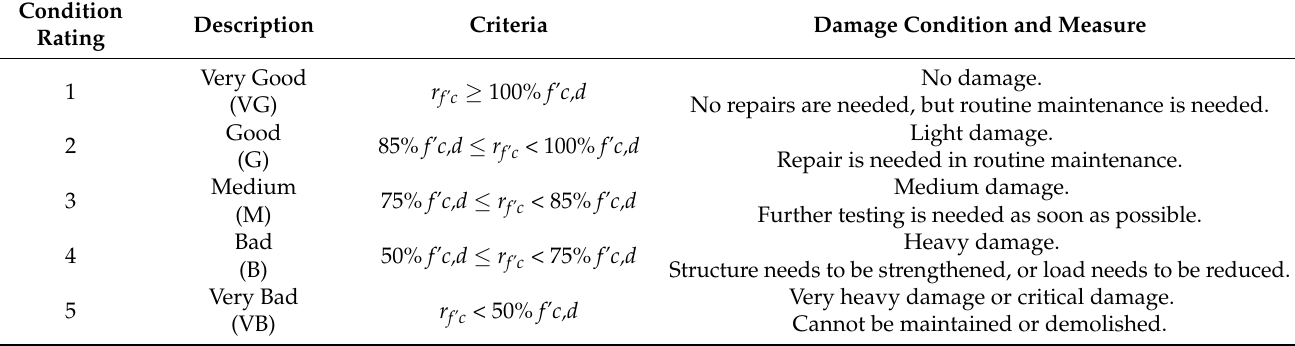
Table 2. Concrete damage condition rating